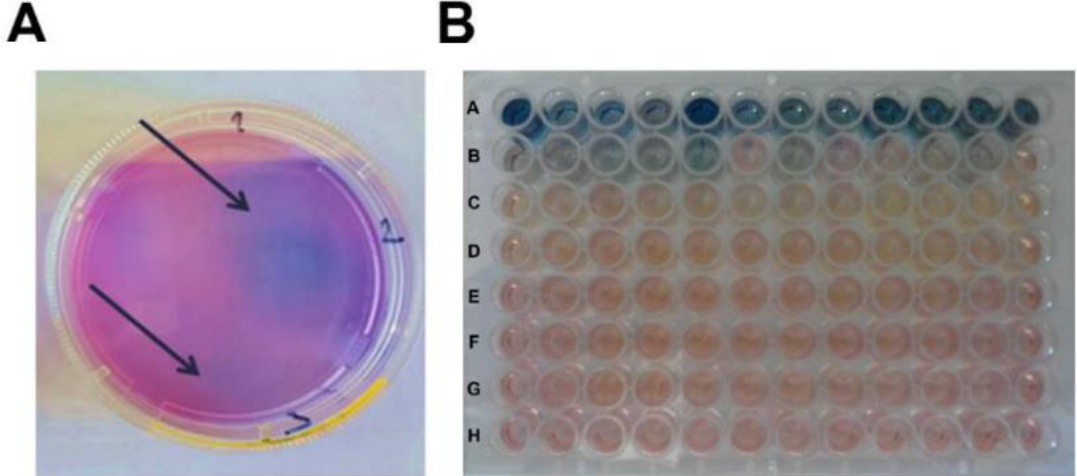
Figure 6. Isolation of recombinant virus using the plaques method. ( A ) Supernatants of the recombination step were used to infect new Vero cells expressing pA104R, which were covered by agarose with X-Gluc. The blue plaques formed were picked and used to infect new cell cultures. ( B ) Isolation of recombinant virus using serial dilutions. (A–E) Supernatants of the recombination step were diluted (1:10–1:100,000) in Dulbecco’s Modified Eagle’s minimal essential medium (DMEM) with X-Gluc and used to infect new Vero cells expressing pA104R. (F–H) The blue-colored supernatants were collected, diluted and used to infect new cells.